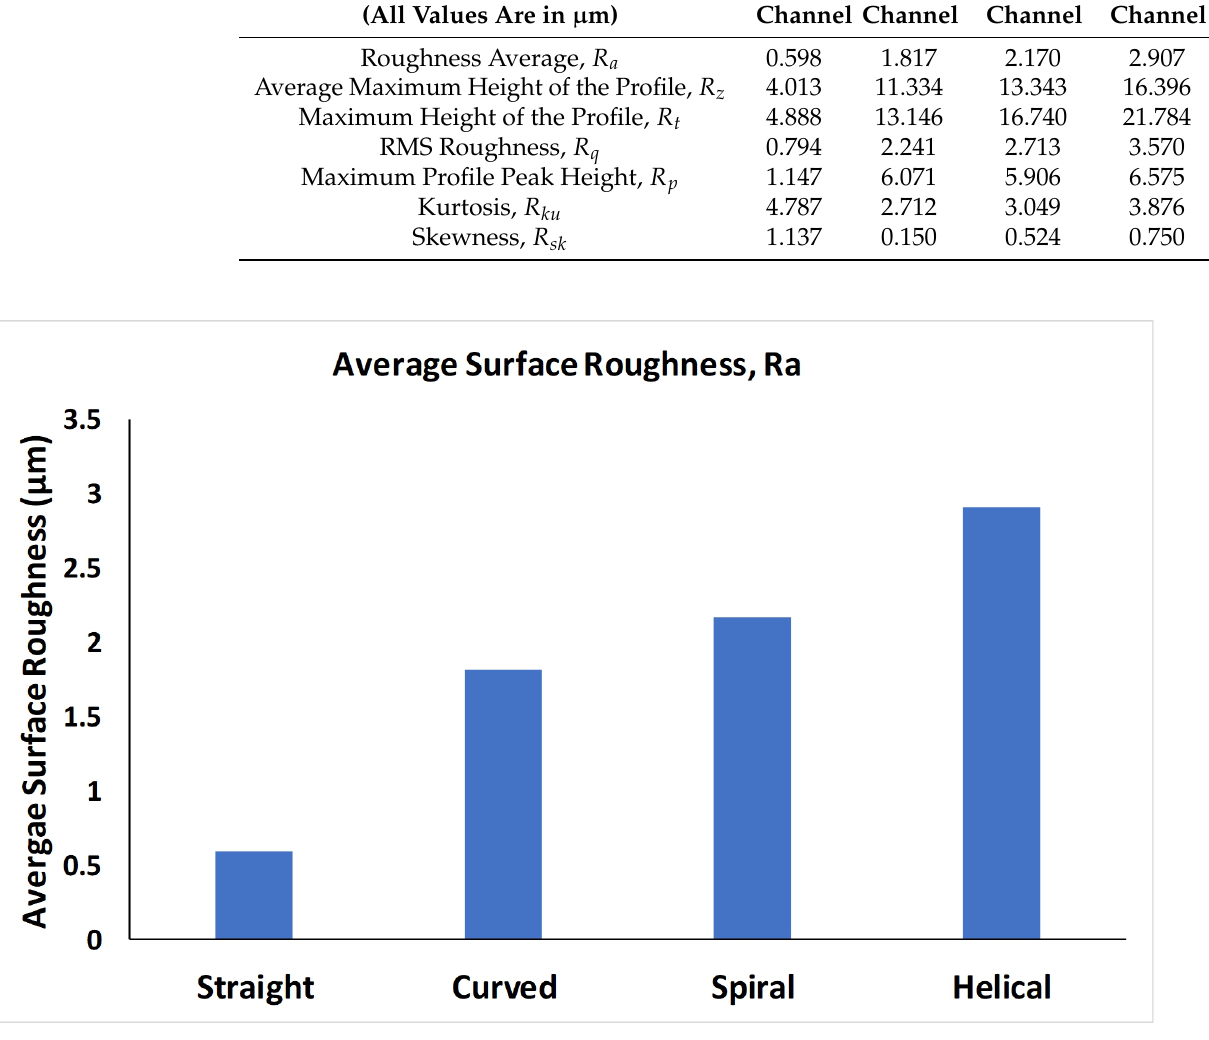
Figure 4. Average surface roughness (Ra) of straight, curved, spiral and helical